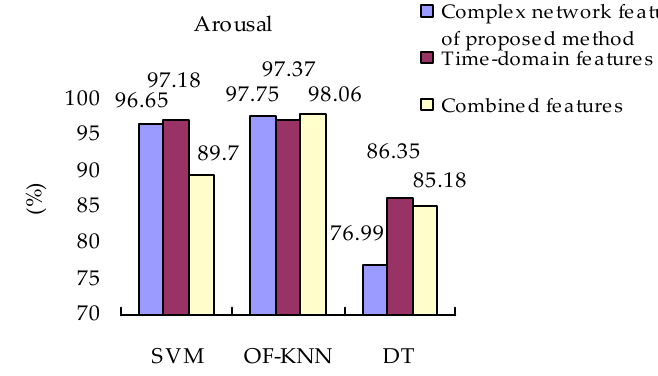
Figure 9. Classification accuracies of valence.